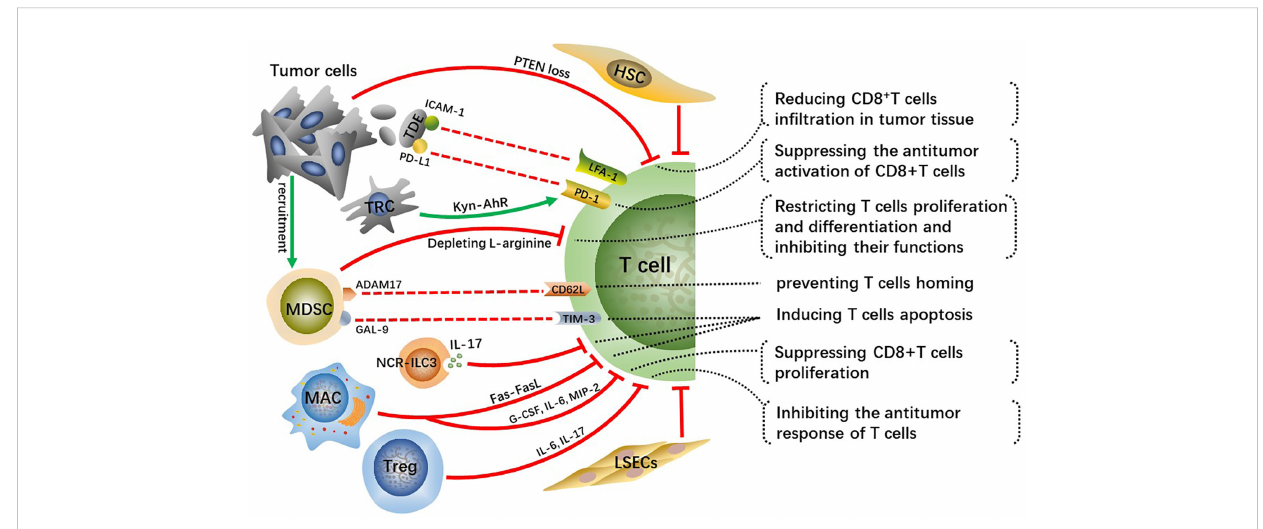
FIGURE 3 Crosstalk effects of other cells on effector T cells directly or indirectly suppress their in fi ltration, activation, proliferation and differentiation, which impairs anti-tumor immune effect of T cells and contributes to HCC malignant